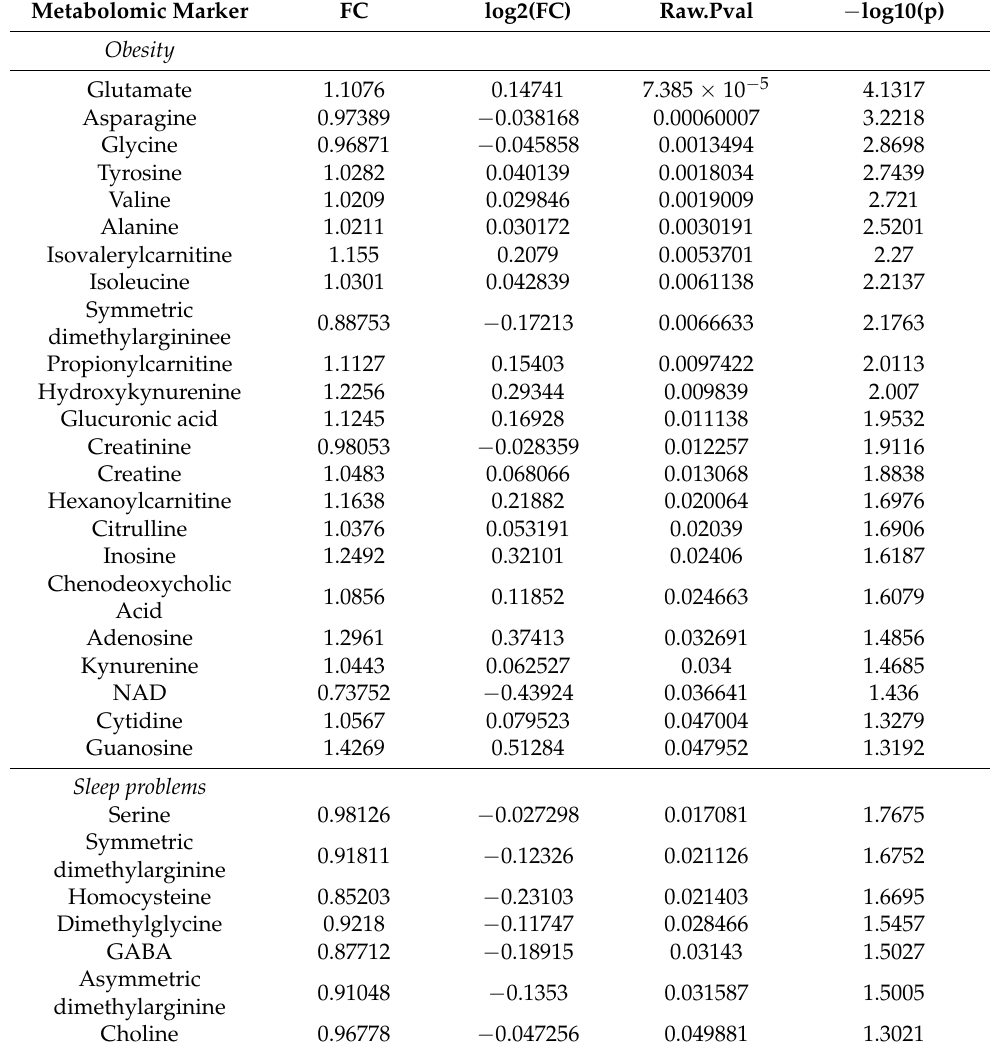
Table 3. Statistical analysis (fold change and t-test) used in volcano plot for elucidating discerning markers between obese (BMI > 30) and non-obese patients, and those with recurring sleep problems and those with normal sleep or only mild sleep